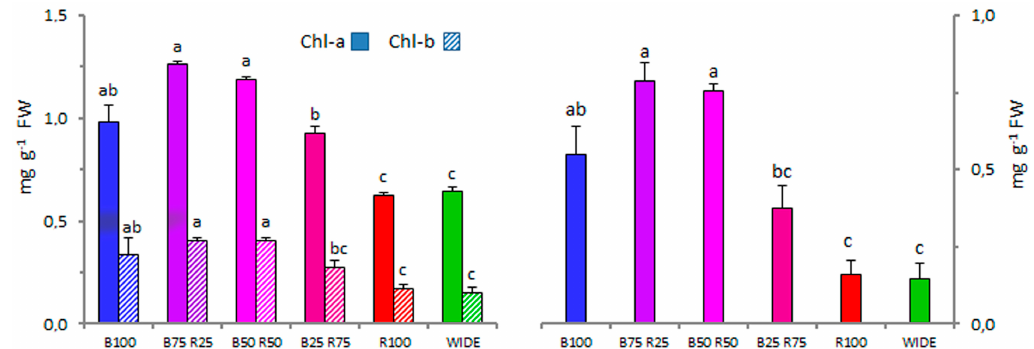
Figure 3. Chlorophyll ( left ) and carotenoid ( right ) content in einkorn shoots subjected to six light treatments. Means followed by the same letters are not statistically different for p < 0.05 (Tukey’s HSD test). Errors bars represent +1 SEM.